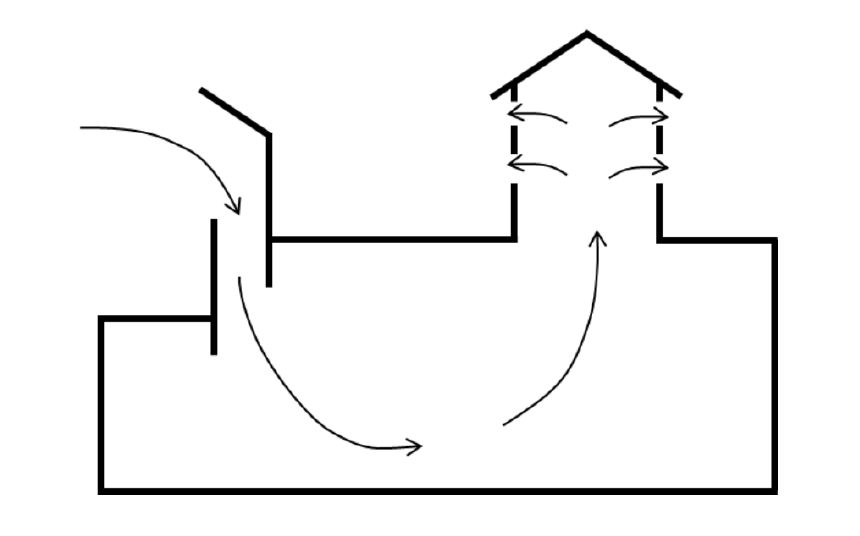
Figure 14. 2D model and working principle of a wind tower.